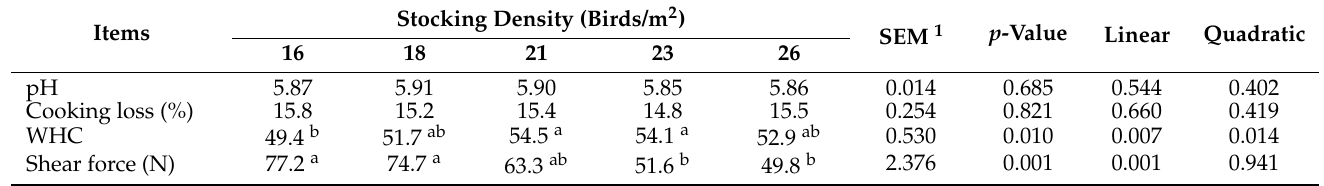
Table 5. Effects of stocking density on breast meat quality of broiler chickens under high temperatures.